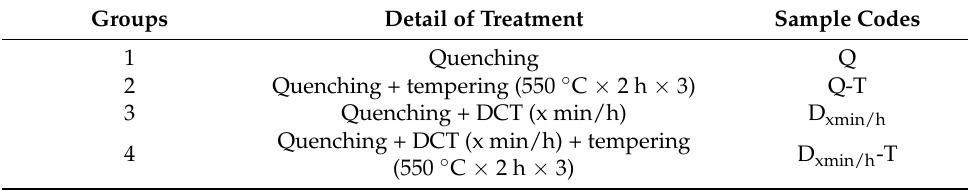
Table 2. Different heat treatments and sample